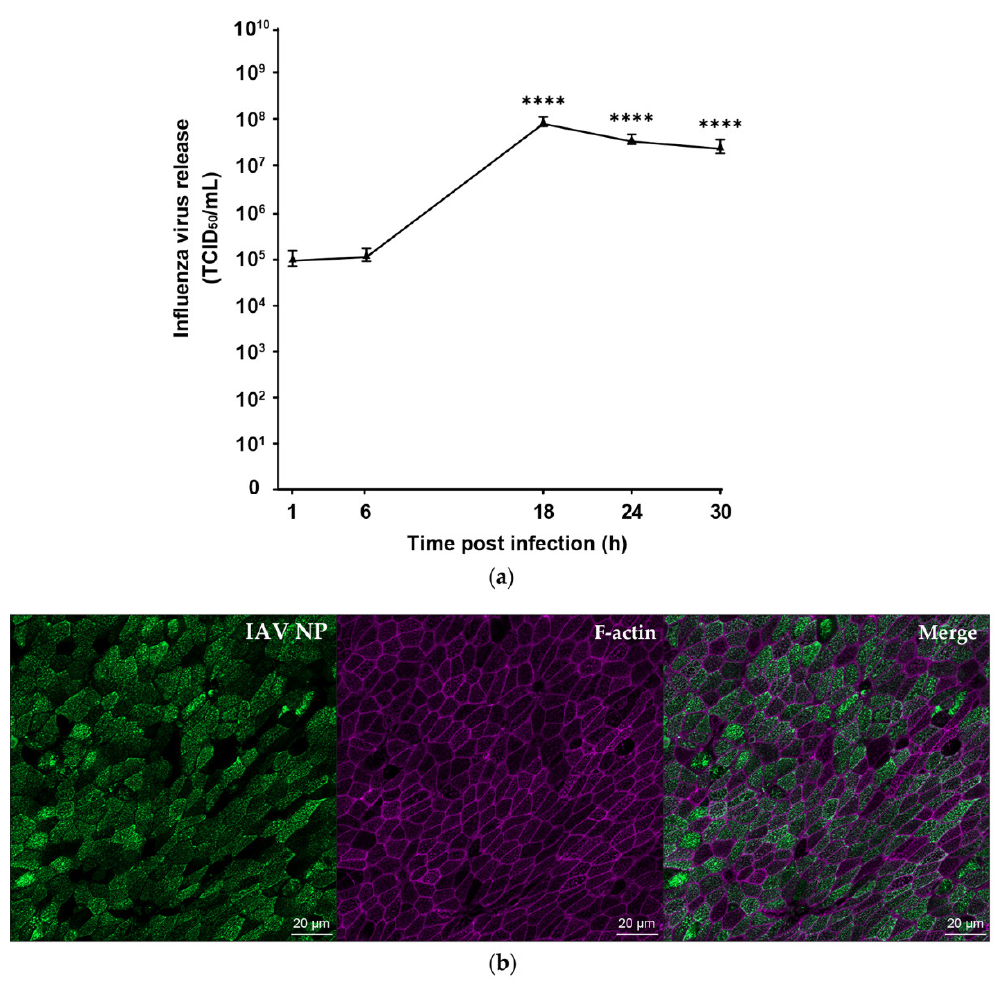
Figure 2. Pandemic influenza A/H1N1pdm09 infects and replicates efficiently in wdNHBE cells. ( a ). Time course of influenza virus release (TCID 50 / mL) from the apical surface of cells infected with H1N1pdm09 (MOI 1) at selected timepoints over a 30 h period postinfection. Data from three independent experiments were pooled and analyzed (Methods) using n = 12 biological replicates per timepoint and are presented as mean of virus release ± SEM. Statistical significance of viral titres compared to the 1 h postinfection IAV level are indicated; ****, p < 0.0001. ( b ) Infectivity of H1N1pdm09 in wdNHBE cells 30 h postinoculation. Cells were stained IAV nucleoprotein (IAV NP, green) and phalloidin (F-actin, cytoskeleton, pink) and the Merge also shown. Maximum intensity projections of en face Z-stacks, 13 slices (12 µ m) representative of three independent experiments and a 20 µm scale bar are shown.